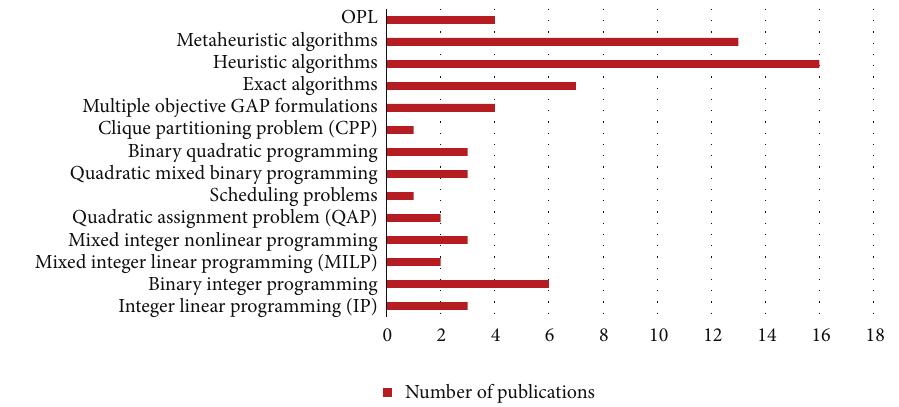
Figure 3: Number of publications per research